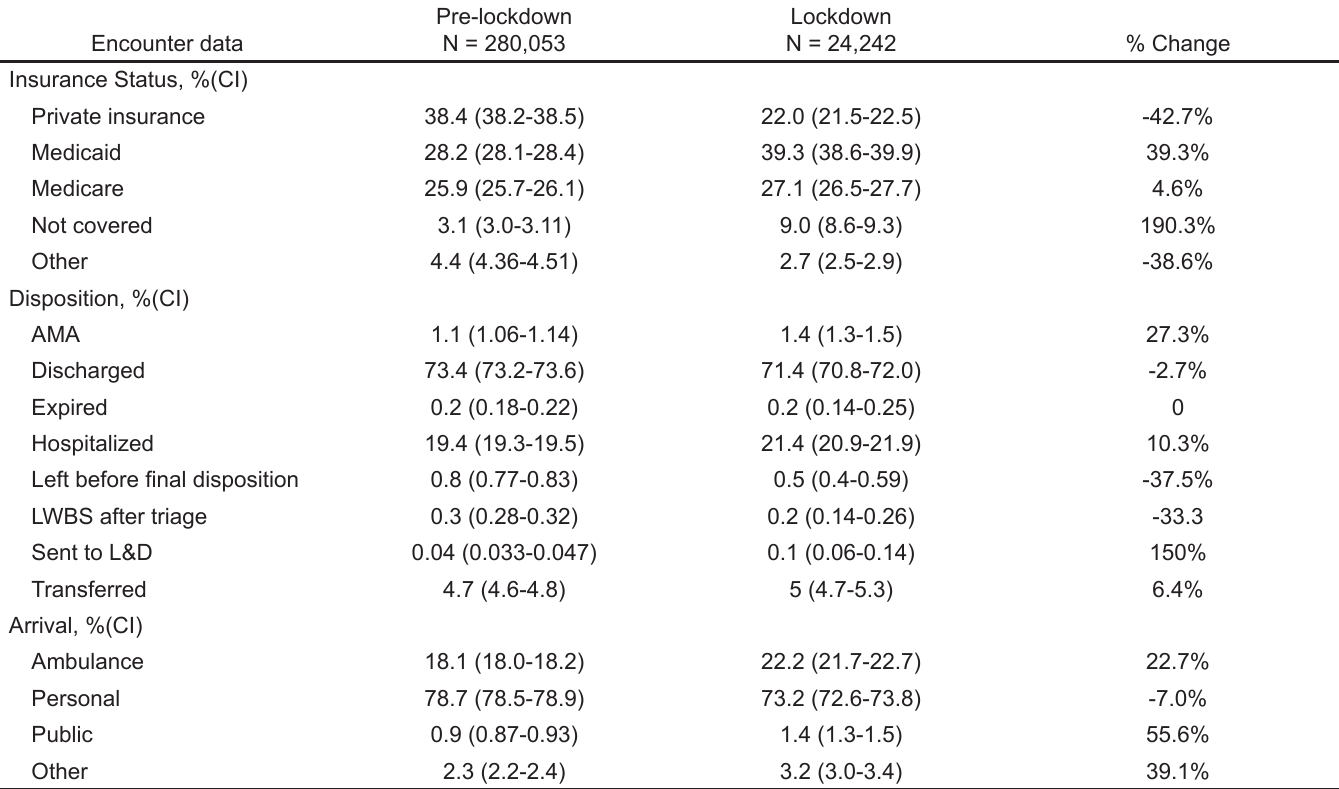
Table 6. Patient-level encounter